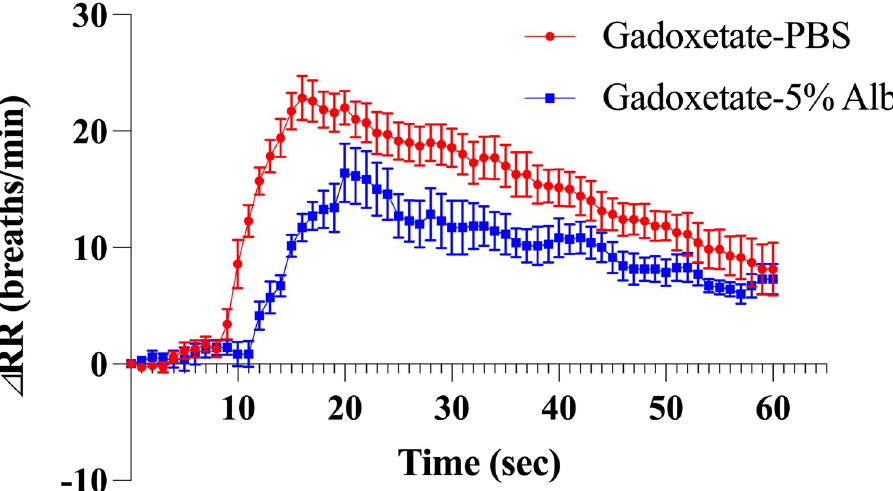
Fig 6. Differences between dilution of gadoxetate disodium with 5% serum albumin and with phosphate-buffered saline. Note.—Error bars represent standard errors (n = 7 rats per group). Injection of phosphate-buffered saline- diluted gadoxetate disodium into the ascending aorta shows the maximum elevation in the respiratory rate of 24.1 breaths/min at 15.7 sec from the start of injection, and tachypnea starts at 9.9 sec. On the other hand, injection of 5% albumin-diluted gadoxetate disodium shows the maximum elevation of 17.0 breaths/min at 18.1 sec from the start of injection, starting at 13.0 sec. Gadoxetate-PBS = injection of phosphate-buffered saline-diluted gadoxetate disodium; Gadoxetate-5% Alb = injection of 5% albumin-diluted gadoxetate disodium; Δ RR = change (increase) in the respiratory